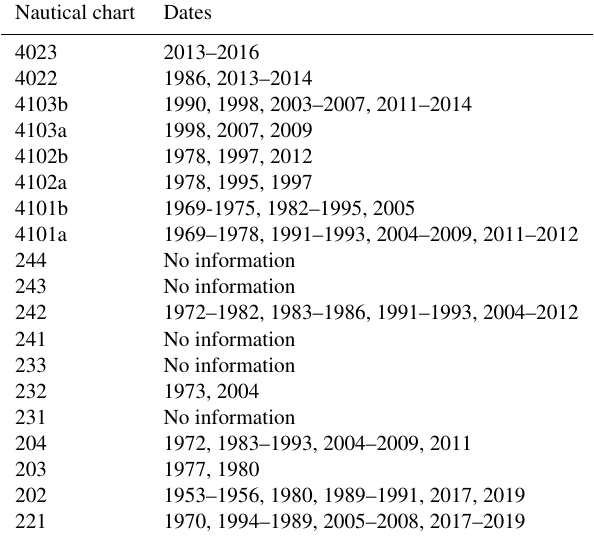
Table A1. Identification of nautical charts and dates of surveys (Brazilian Navy).